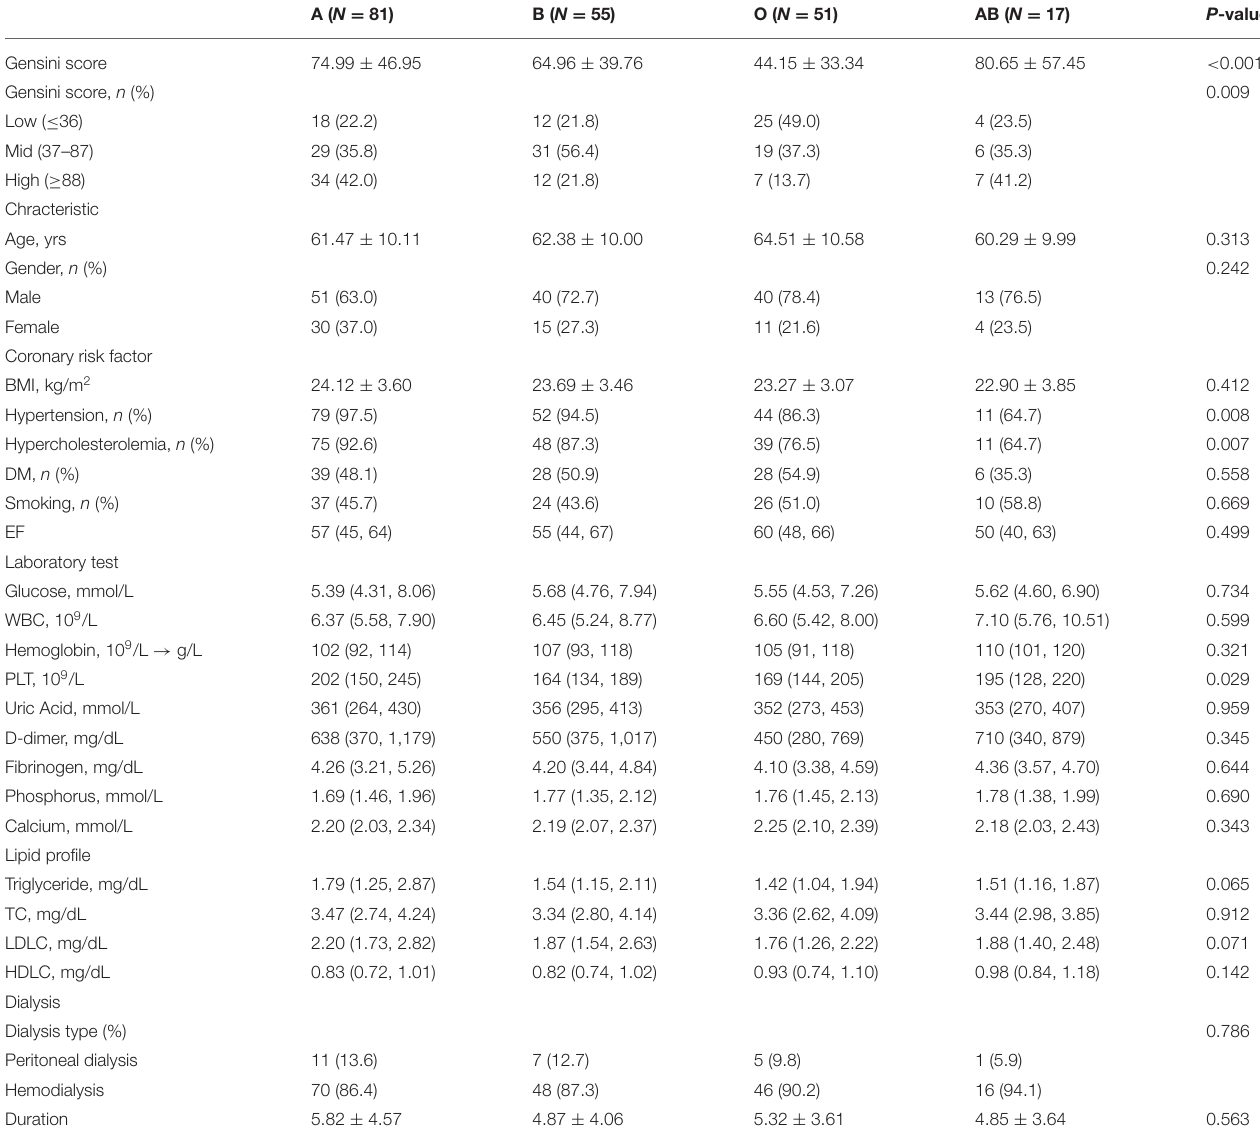
TABLE 3 | Baseline characteristics of different blood group types ESRD patients with